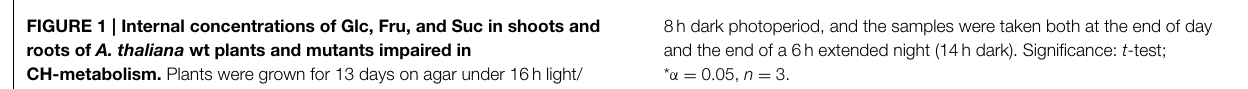
8h dark photoperiod, and the samples were taken both at the end of day and the end of a 6h extended night (14h dark). Significance: t -test; * α = 0 . 05 , n = 3